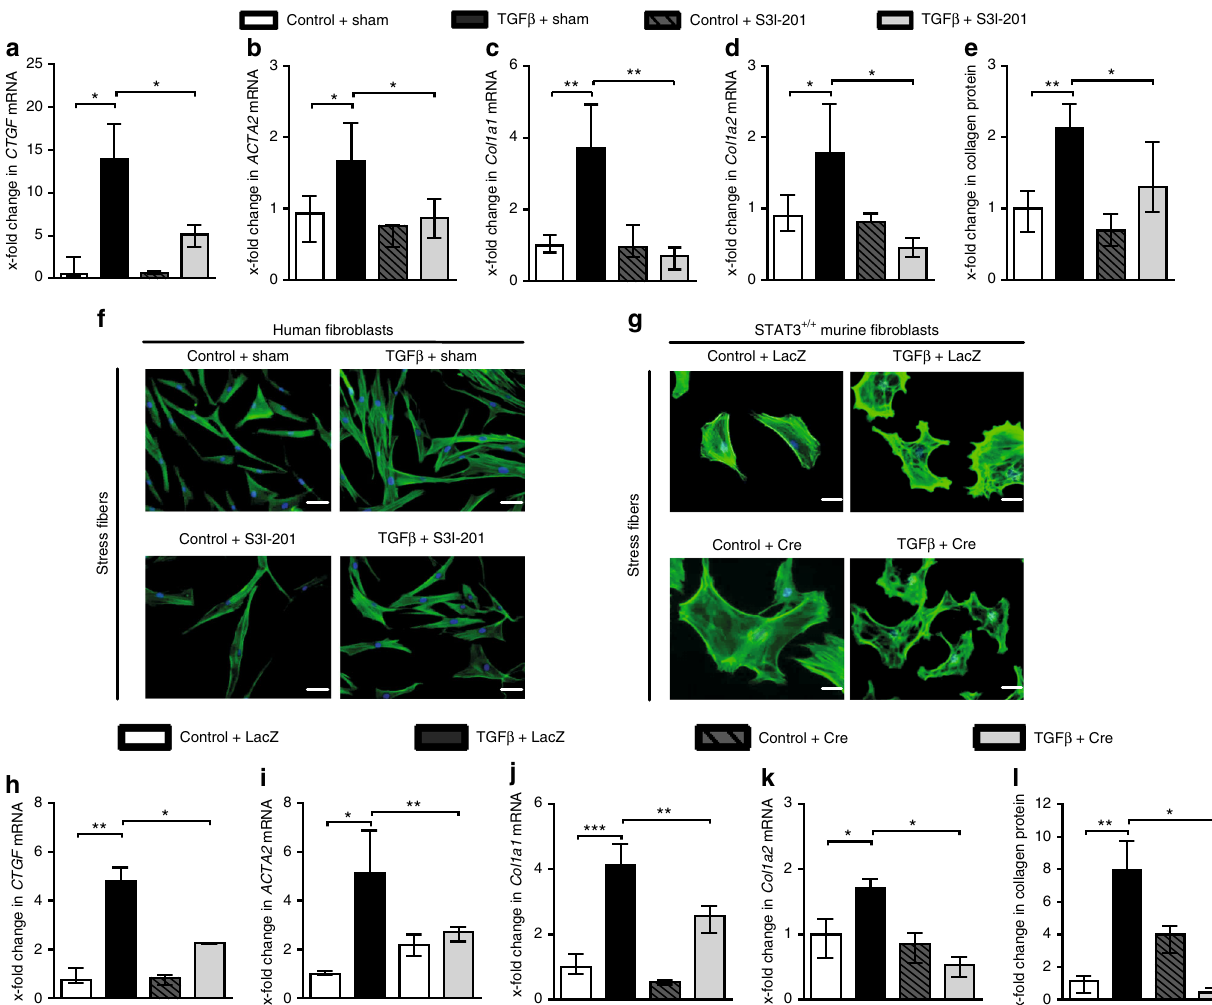
Fig. 6 Inactivation of STAT3 inhibits TGF β -induced myo fi broblast differentiation and collagen release. a – f Effect of the STAT3 inhibitor S3I-201 on the mRNA levels of a CTGF , b ACTA2 , c COL1A1 , d COL1A2 , and e collagen protein ( n = 4 – 7 and 2 technical replicates for all experiments) in human dermal fi broblasts. f Representative images of immuno fl uorescence staining for stress fi bers at 200-fold magni fi cation. Horizontal scale bar, 100 μ m. g – l Responsiveness of AAV-Cre virus-infected mouse fi broblasts from STAT3 fl / fl mice to TGF β stimulation, as compared to AAV-LacZ virus-infected fi broblasts, which served as control: g Representative images of immuno fl uorescence staining for stress fi bers at 200-fold magni fi cation. Horizontal scale bar, 100 μ m. mRNA levels of h Ctgf , i Acta2 , j Col1a1 , k Col1a2 , and l collagen protein ( n = 6 with 2 technical replicates for all experiments). Results are shown as median ± interquartile range (IQR). Signi fi cance was determined by Mann – Whitney test, as compared to the unstimulated control fi broblasts or TGF β -stimulated control fi broblasts, respectively. * P < 0.05; ** P < 0.01, *** P < 0.001. AAV adeno-associated effects of S3I-201 are due to off-target effects, we con fi rm these results by a genetic approach using fi broblasts depleted of STAT3.